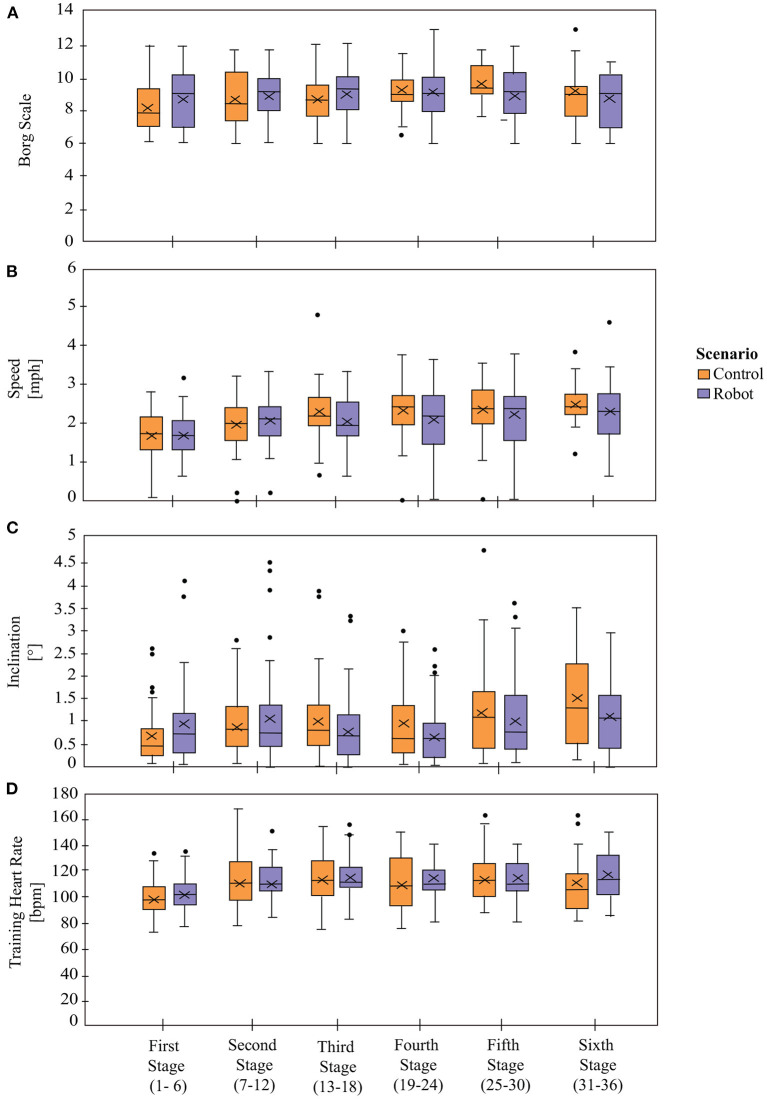
Physiological parameters between Control and Robot conditions. Panel (A) shows the exertion levels of the patients based on Borg Scale. Panels (B,C) show the Gait Speed and the Treadmill's Inclination, respectively. Panel (D) represent the Training Heart Rate (THR). X denotes the mean value per stage.